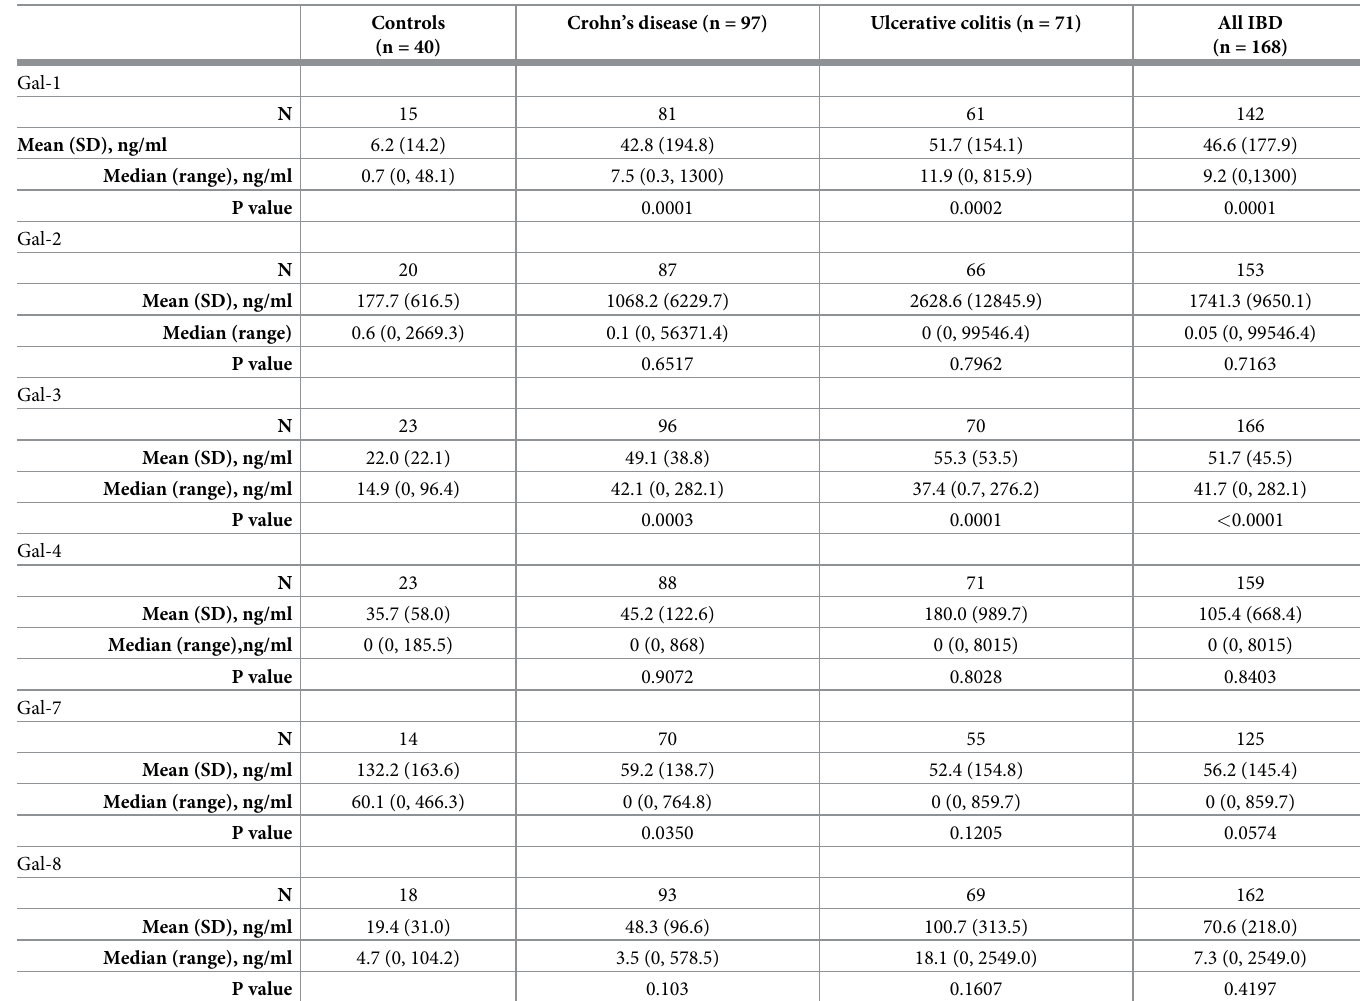
Table 2. Galectin levels in healthy controls, UC and CD